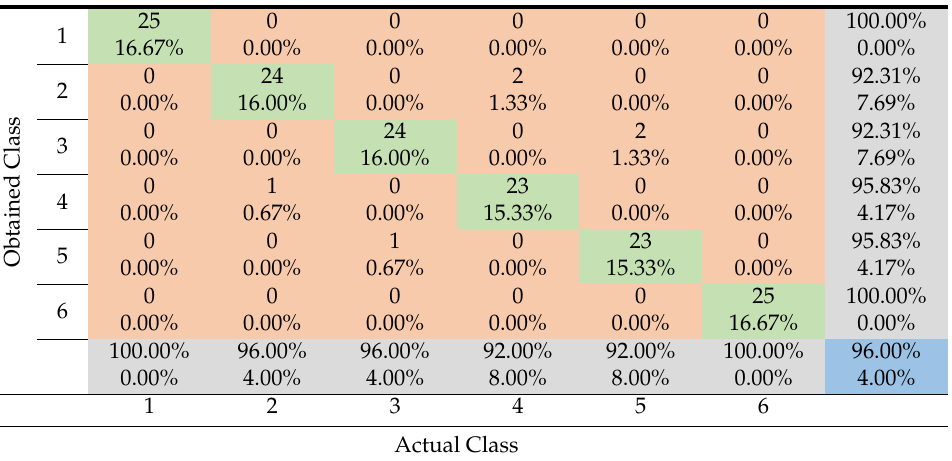
Table 6. Error analysis of fault